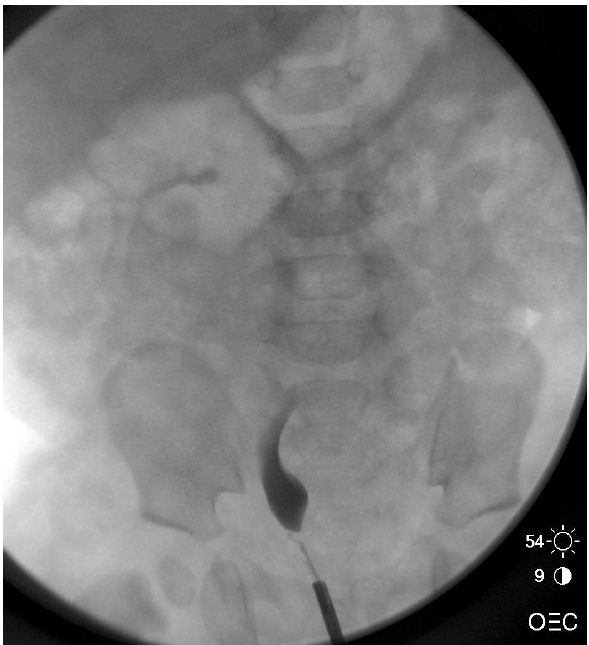
FIGURE 5. Retrograde pyelogram of adynamic distal segment in obstructive